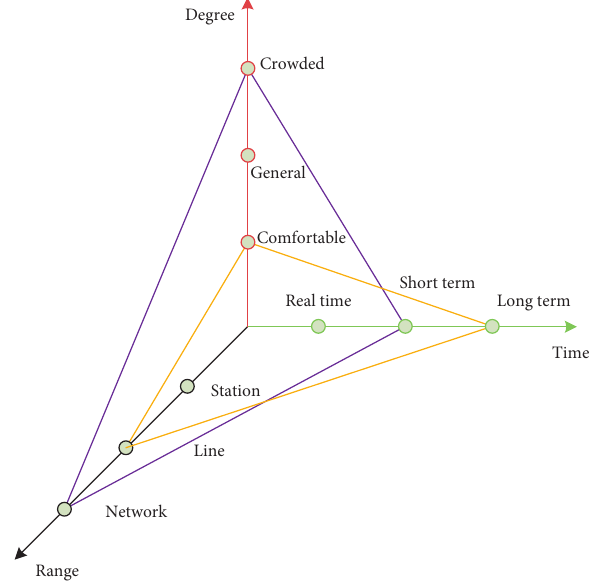
Figure 2: Factors affecting the passenger flow impact index under emergencies.